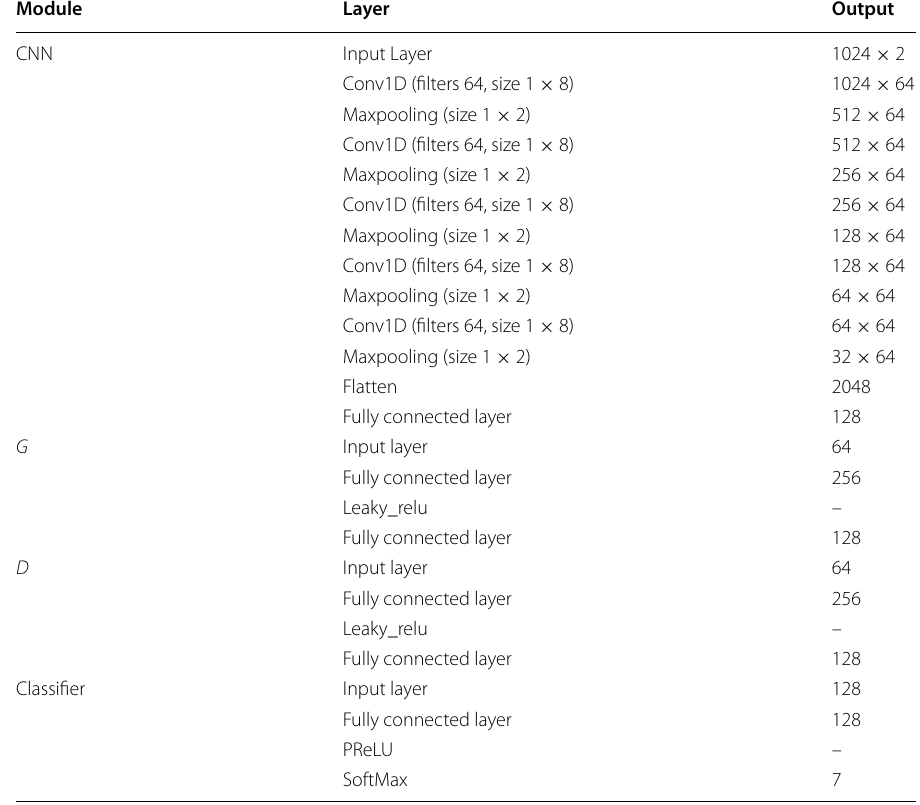
G is the generator module, and D is the discriminator module